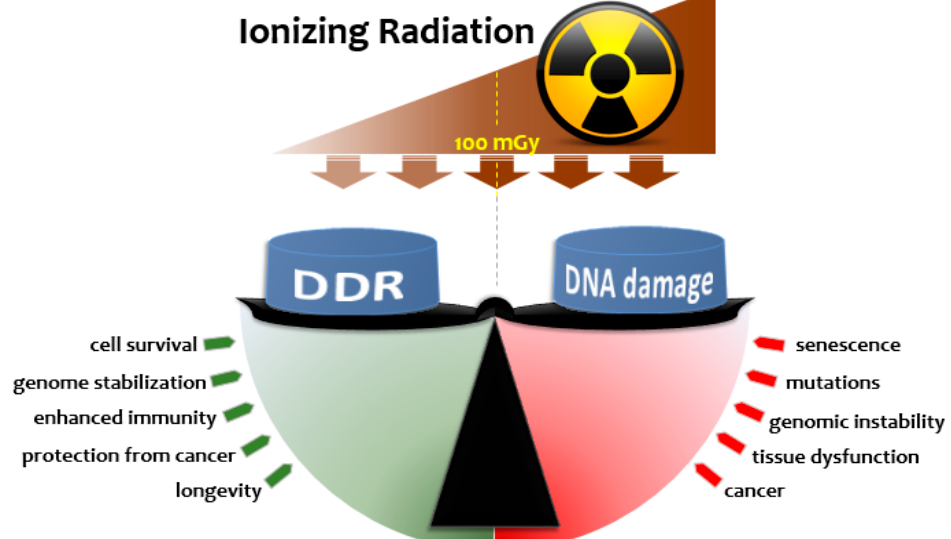
Figure 2. A dynamic interplay between the amount of DNA damage and DNA damage response (DDR) upon exposure to IR determines the biological outcome in cellular and organismal